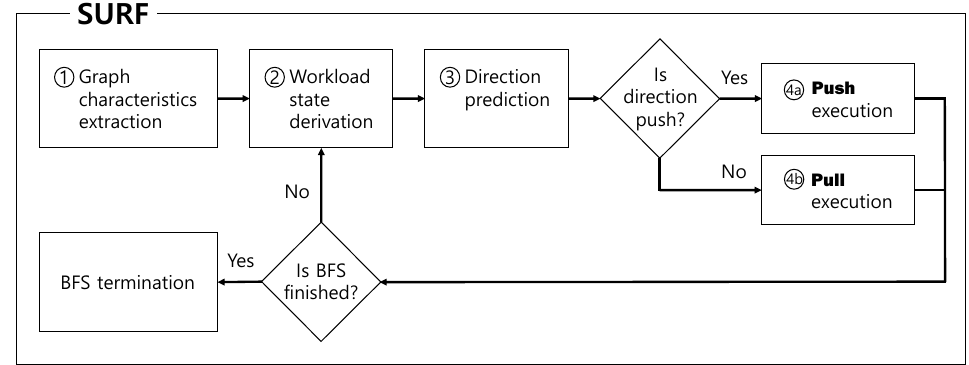
Figure 4. Workflow of